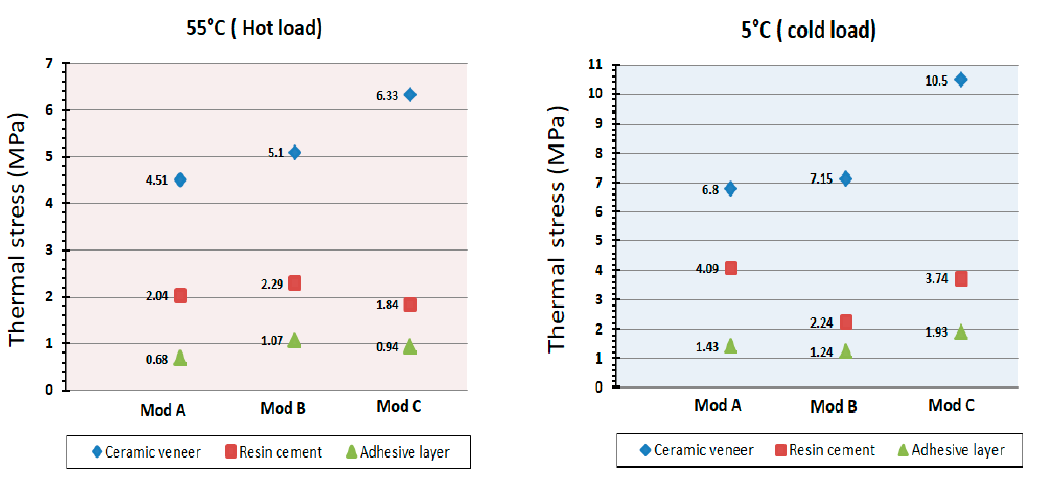
Figure 11. Maximum von Mises thermal stresses (MPa) in three layers of the components after application of cold (5 °C) and hot (55 °C) thermal loads.